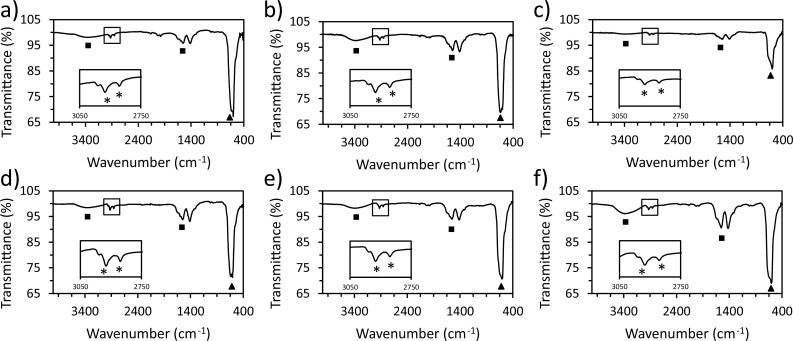
FTIR spectra of the following temperature profiles: 20°C/min ramp with a) 5 min at 300°C, b) 15 min at 300°C, c) 30 min at 300°C, and 10°C/min ramp with d) 5 min at 300°C, e) 15 min at 300°C, and f) 30 min at 300°C. Asterisks represent oleyl groups, squares correspond to amine groups, and triangles show the vibration of Mn-O and Mn-O-Mn bonds. The oleyl group spectral regions are enlarged in the boxed insets to resolve the two distinct peaks.